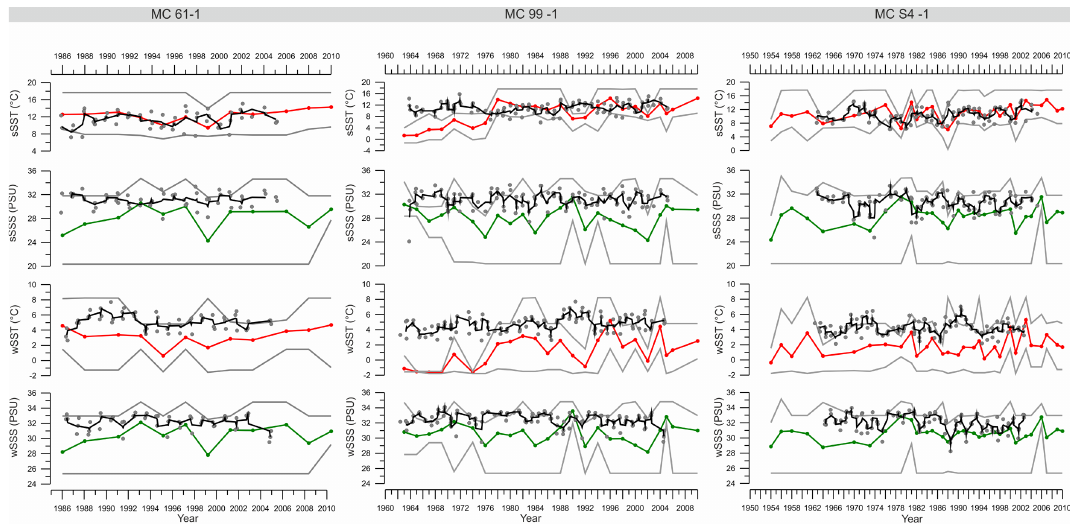
Fig. 8. Winter and summer SST and SSS reconstructions based on cyst assemblages at every core site; red line: SST; green: SSS; grey surrounding lines: minimum and maximum estimates for each reconstructed value calculated from the set of the 5 selected analogues; grey dots: instrumental temperatures and salinities measured at the respective mooring station, Røberg for MC 61-1 and MC 99-1 and Ytterøy for MC S4-1; black lines are the three-point running average of the instrumental temperatures and